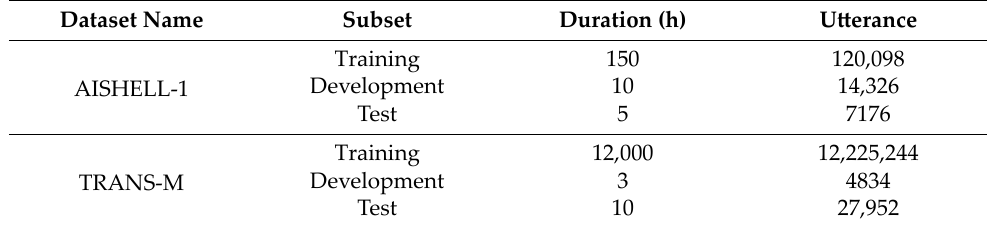
Table 1. The details of the speech recognition corpus.